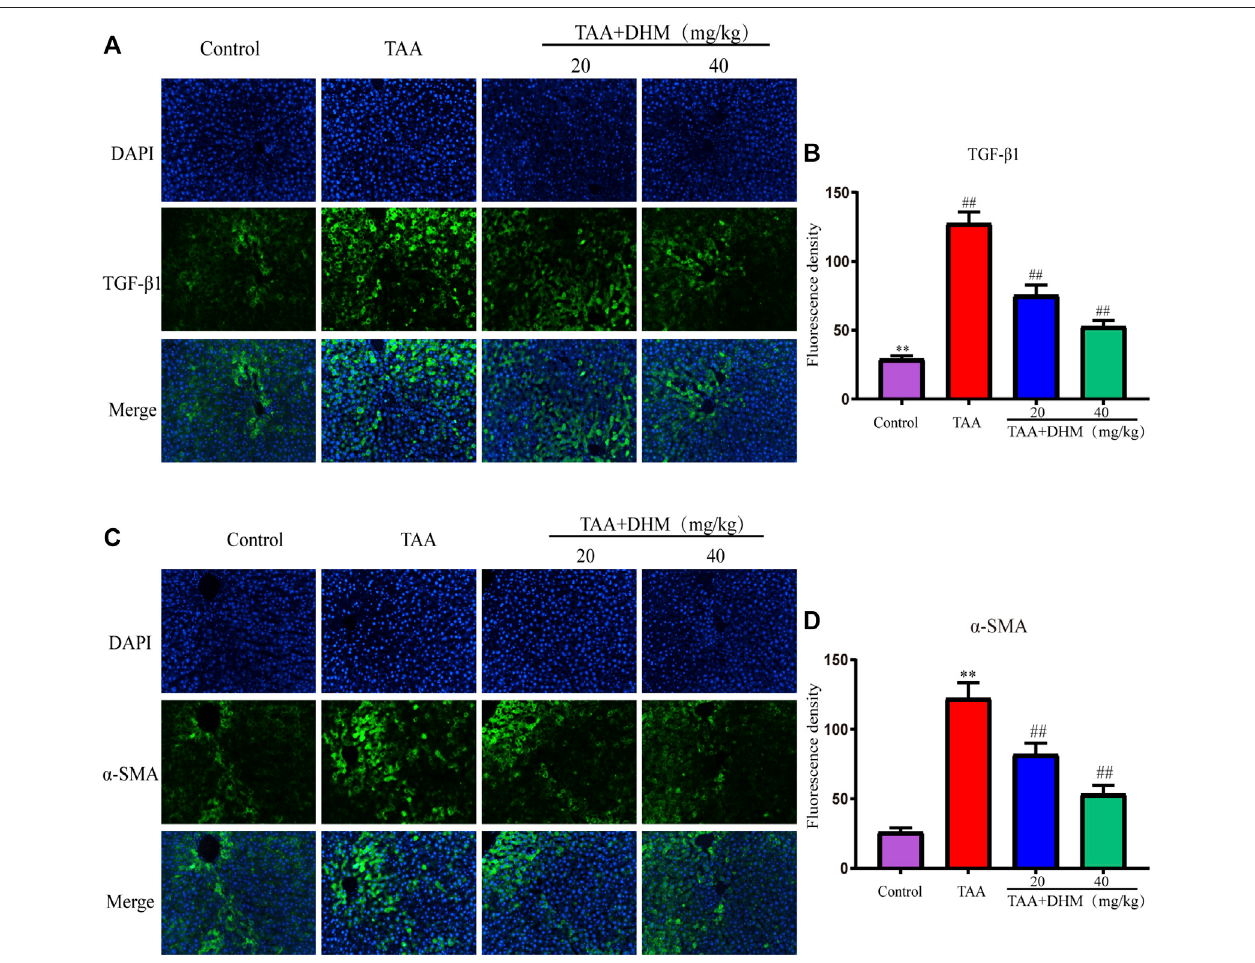
FIGURE 3 | DHM alleviated TAA-induced activation of hepatic stellate cells. The protein expression levels of TGF- β 1 (A) and Fluorescence density (B) , The protein expression levels of α -SMA (C) and Fluorescence density (D) ; Data was expressed as the mean ± SD. The differences between groups were analyzed by two tailed T-test or one-way analysis of variance (ANOVA). ** p < 0.01, * p < 0.05 versus control group; ## p < 0.01, # p < 0.05 versus TAA group.